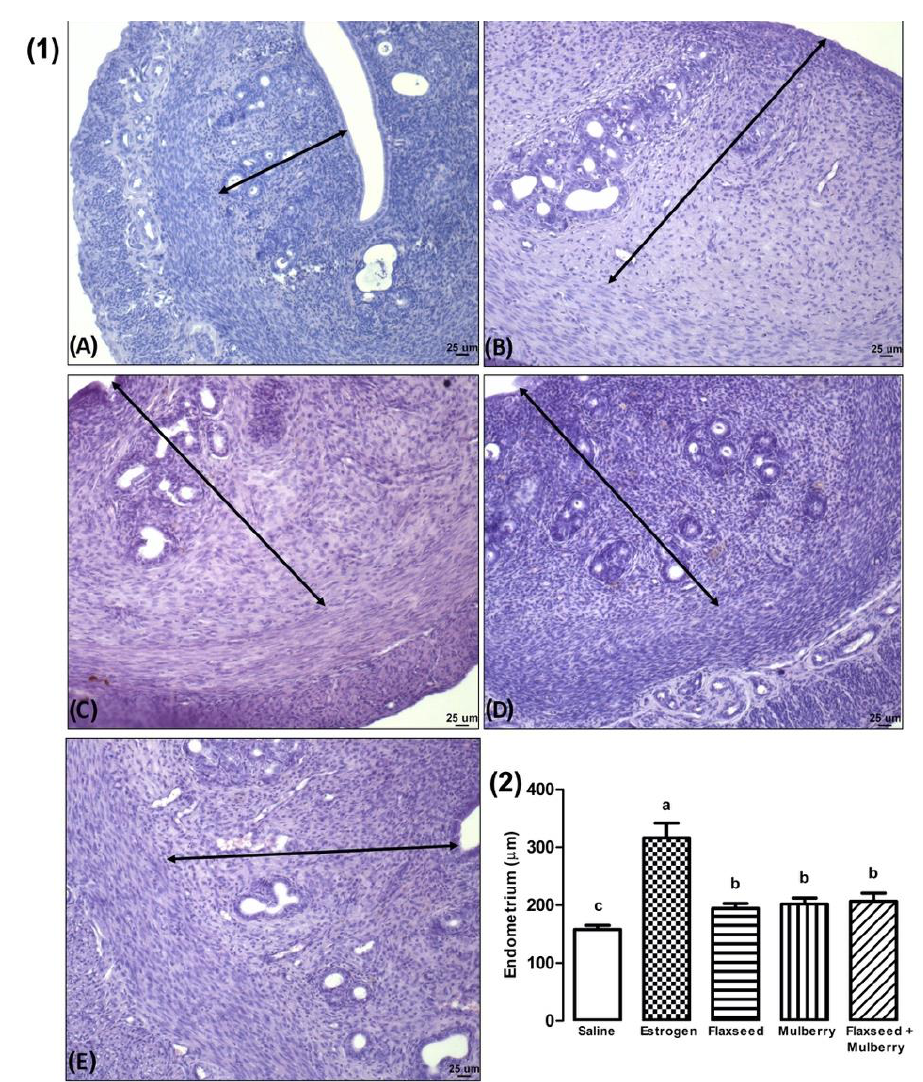
Figure 4. ( 1 ) Photomicroscopy (HE, 10 × ) of the endometrium of animals treated with saline ( A ), estrogen ( B ), flaxseed extract ( C ), mulberry extract ( D ), and flaxseed + mulberry ( E ). Arrow length: the thickness of the endometrium ( µ m). ( 2 ) Endometrial length ( µ m) of the different groups analyzed. The bars with the same letter do not differ statistically from each other by the Scott–Knott test ( p < 0.05). Values represent means ± standard deviation.